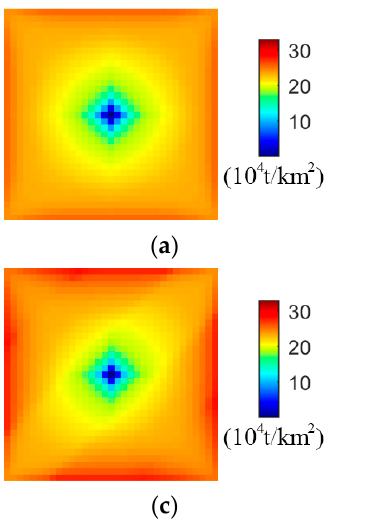
Figure 12. Abundance of predominant remaining oil with different permeability strips. ( a ) Homo- geneous distribution; ( b ) vertical distribution; ( c ) diagonal distribution; ( d ) block-like distribution.